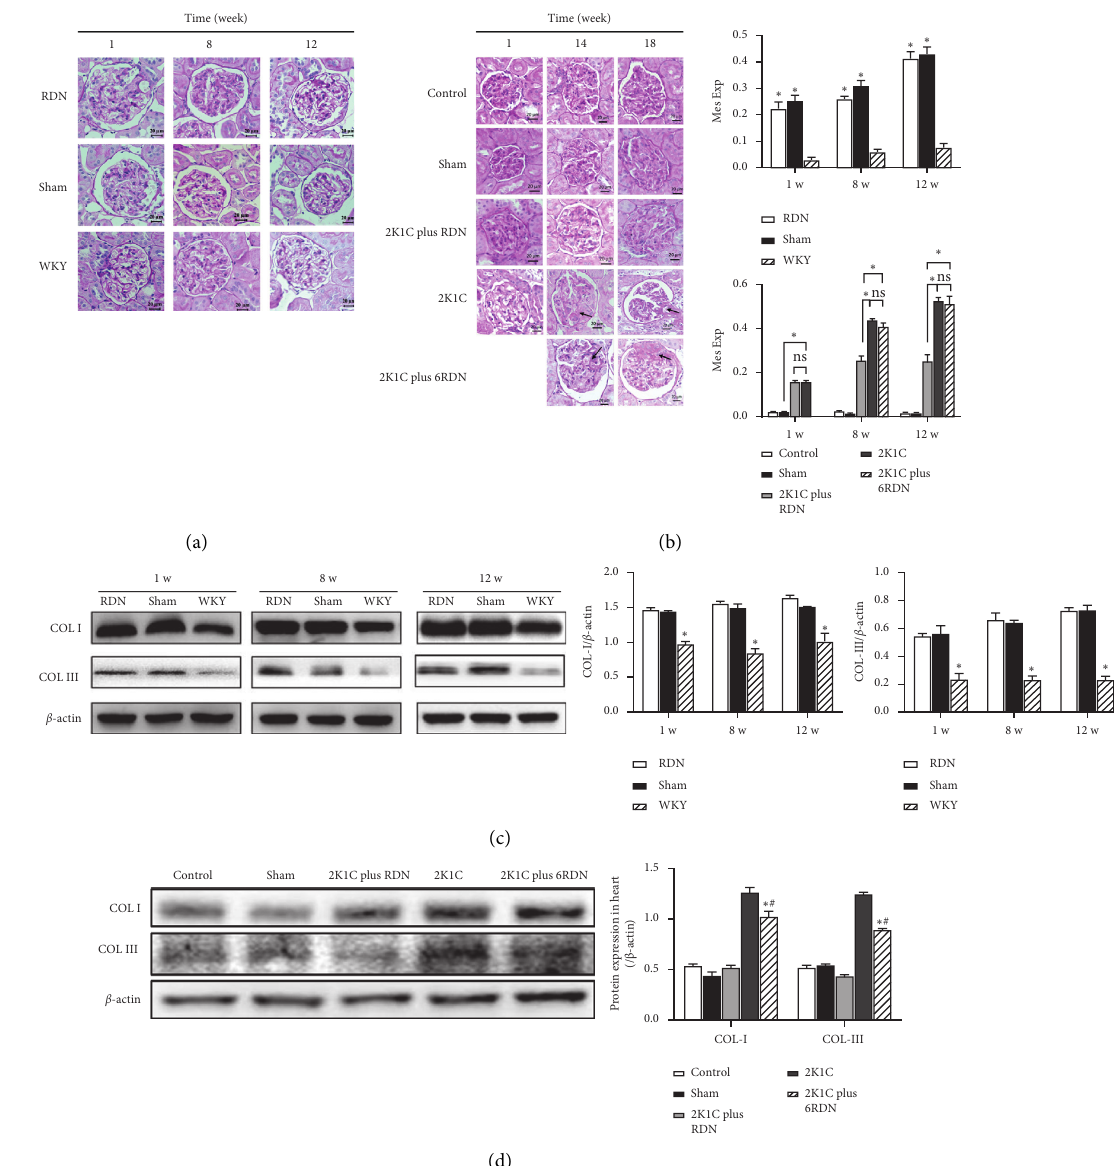
Figure 4: (a) Representative sections of kidney tissues with periodic acid-Schiff staining in SHRs. (b) Representative sections of kidney tissues with periodic acid-Schiff staining in SDs. (c) The protein expression and quantification of Col I and Col III protein in the kidney of SHRs. ∗ p < 0 . 05. (d) The protein expression of Col I and Col III protein in the kidney of SDs. ∗ p < 0 . 05 versus the control group ( n � 4), sham group ( n � 3), and 2K1C plus RDN group ( n � 4). # p > 0 . 05 versus the 2K1C